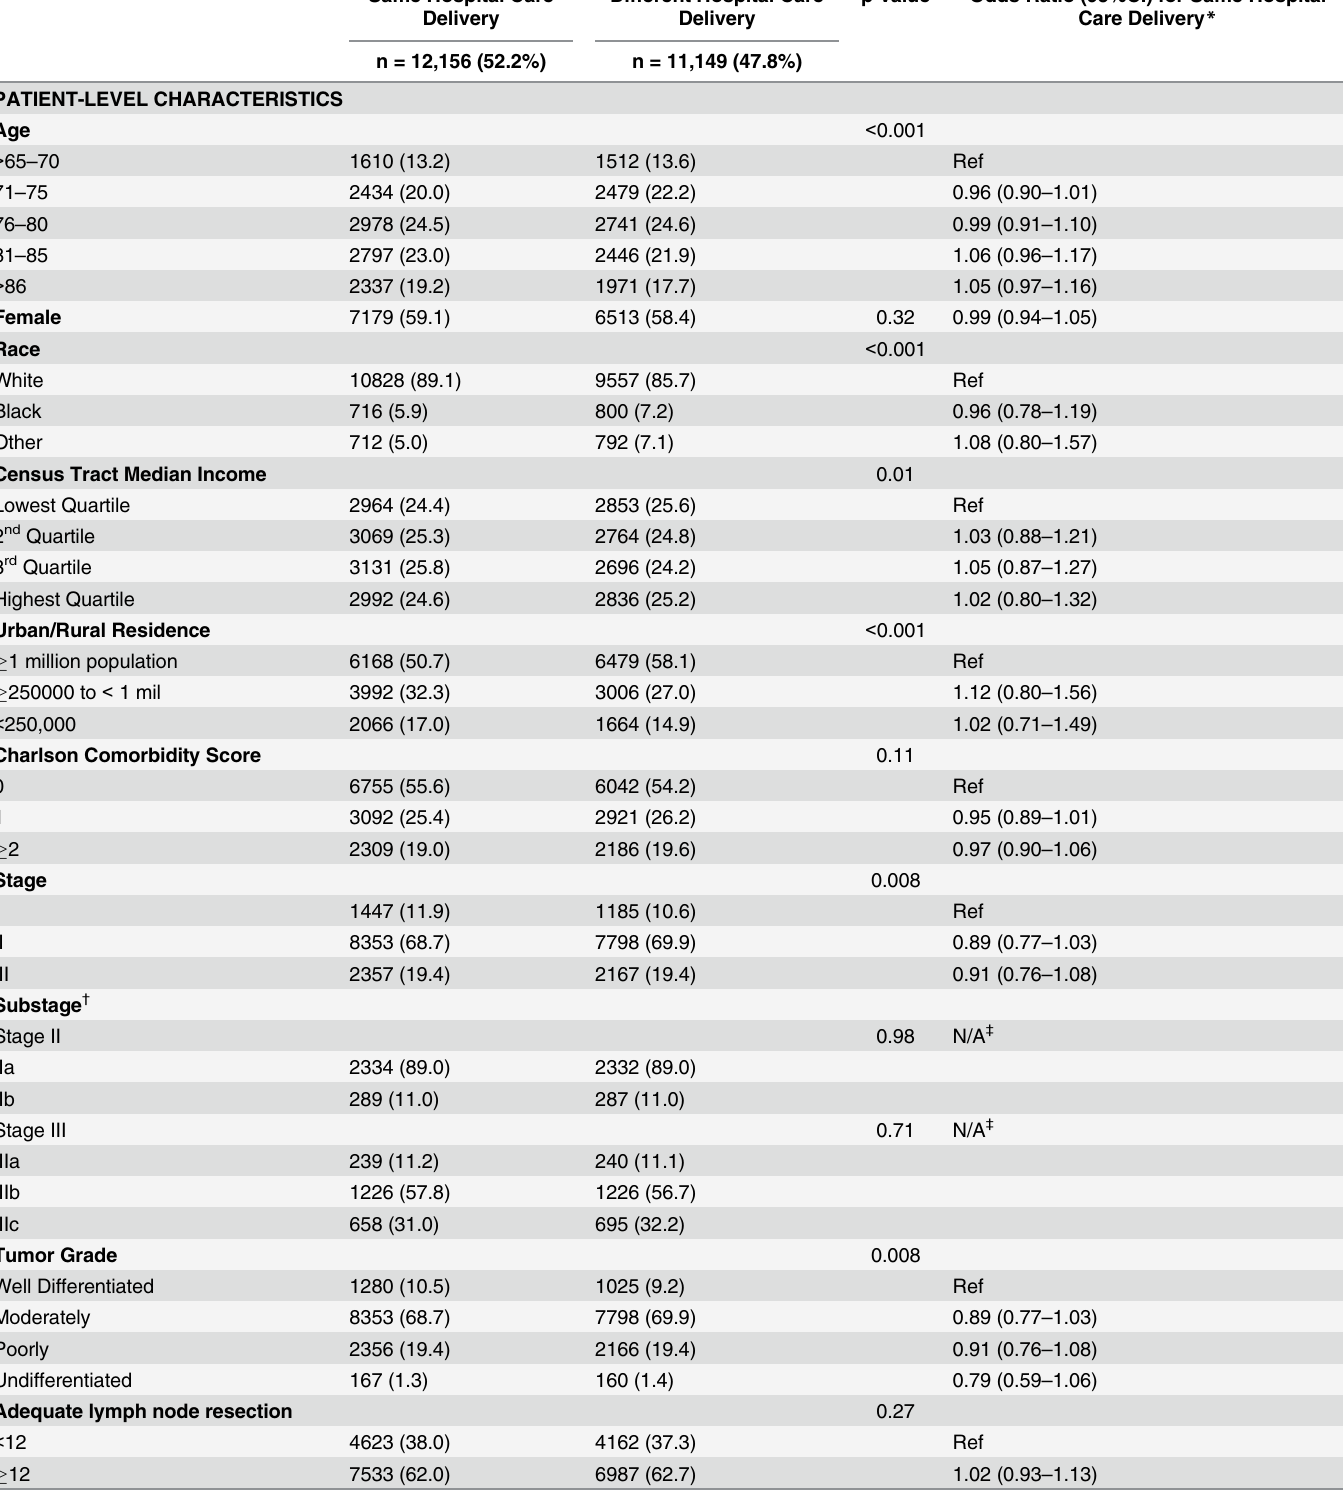
Table 1. Characteristics colon cancer patients, by receipt of same versus different hospital primary care and surgical